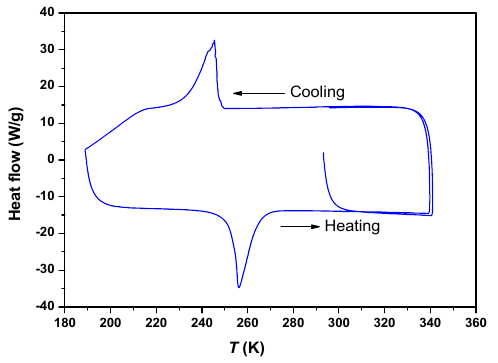
Figure 1. Differential scanning calorimetry (DSC) curve of the columnar-grained Cu 71 Al 17.5 Mn 11.5 shape memory alloy (SMA; heating/cooling rate of 10 K/min).